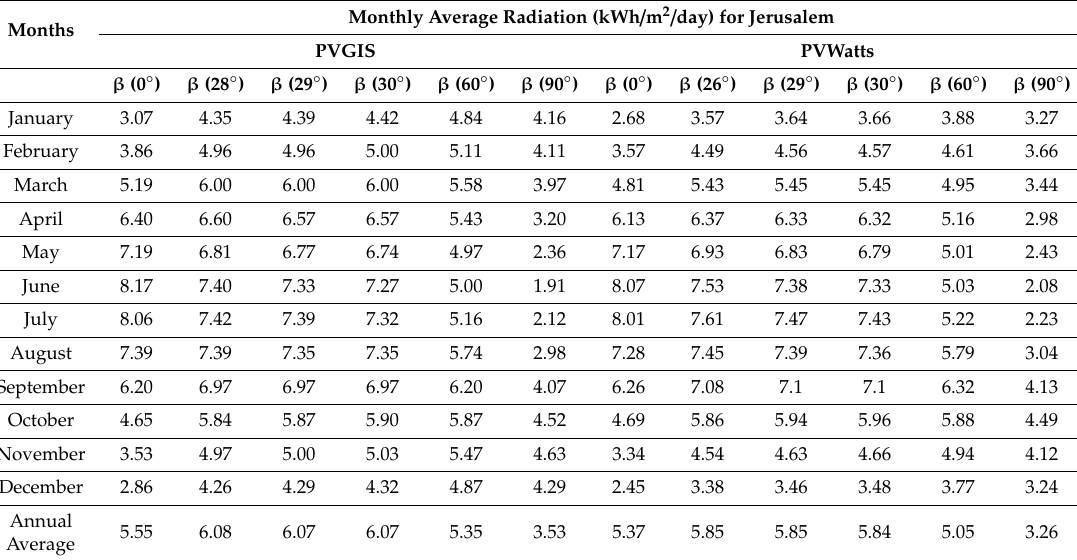
Table 15. The monthly average global radiation in Jerusalem for different tilt angles ( β ). Months